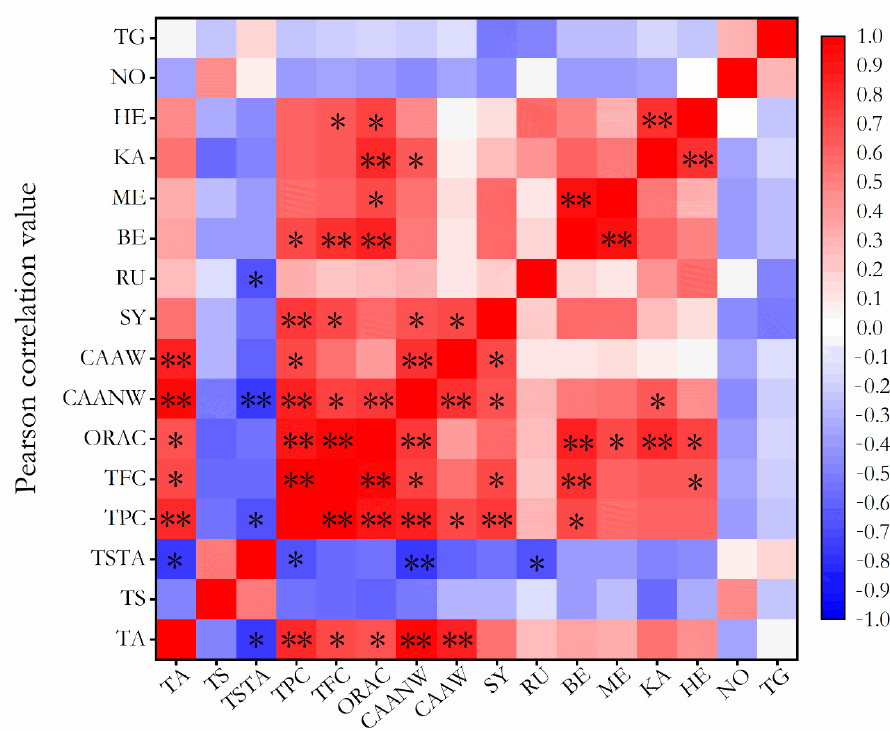
Figure 6. Heat map of the correlation analysis among titratable acid, total sugar, total phenolics, total flavonoids, phytochemical components, and antioxidant activities. TA: titratable acid; TS: total